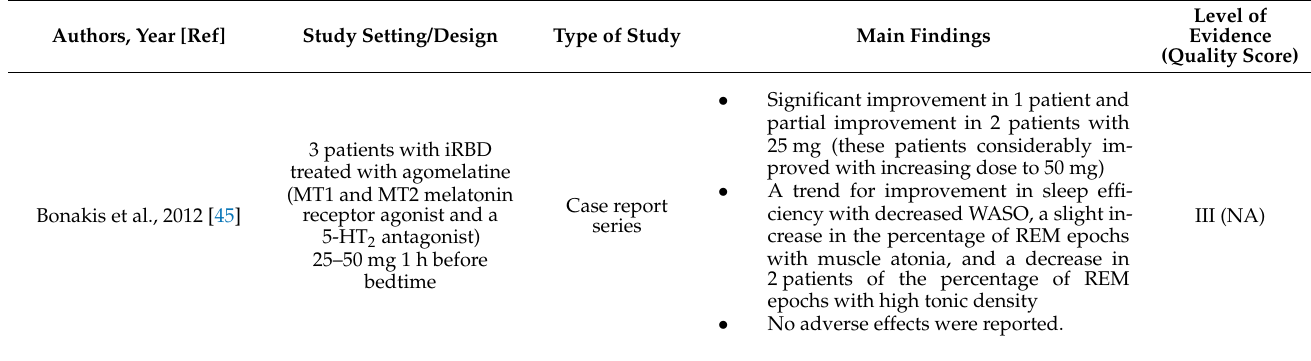
Table 3. Studies describing effects of melatonin analogues in patients with